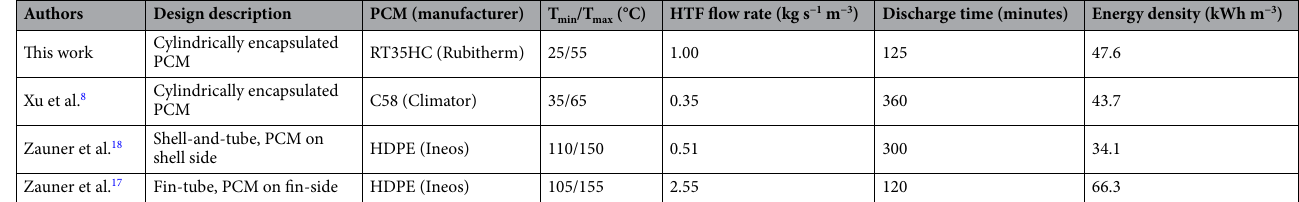
Table 2. Parameters and testing conditions of the previously published latent heat storage